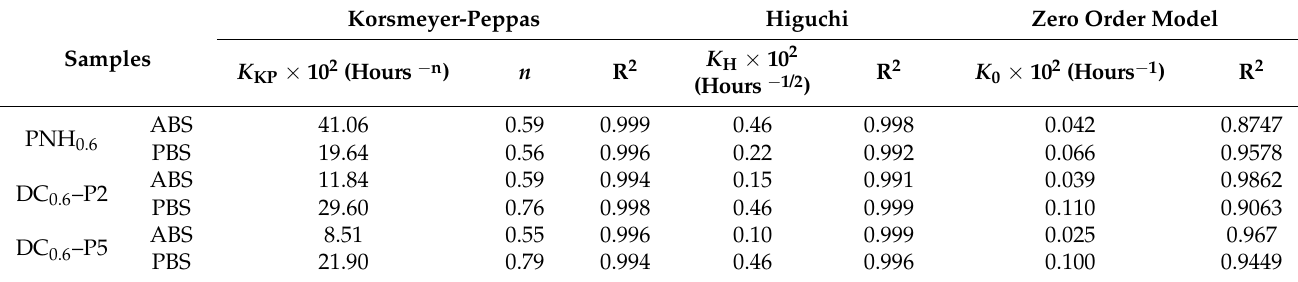
Table 3. Release parameters corresponding to Met-loading hydrogels .